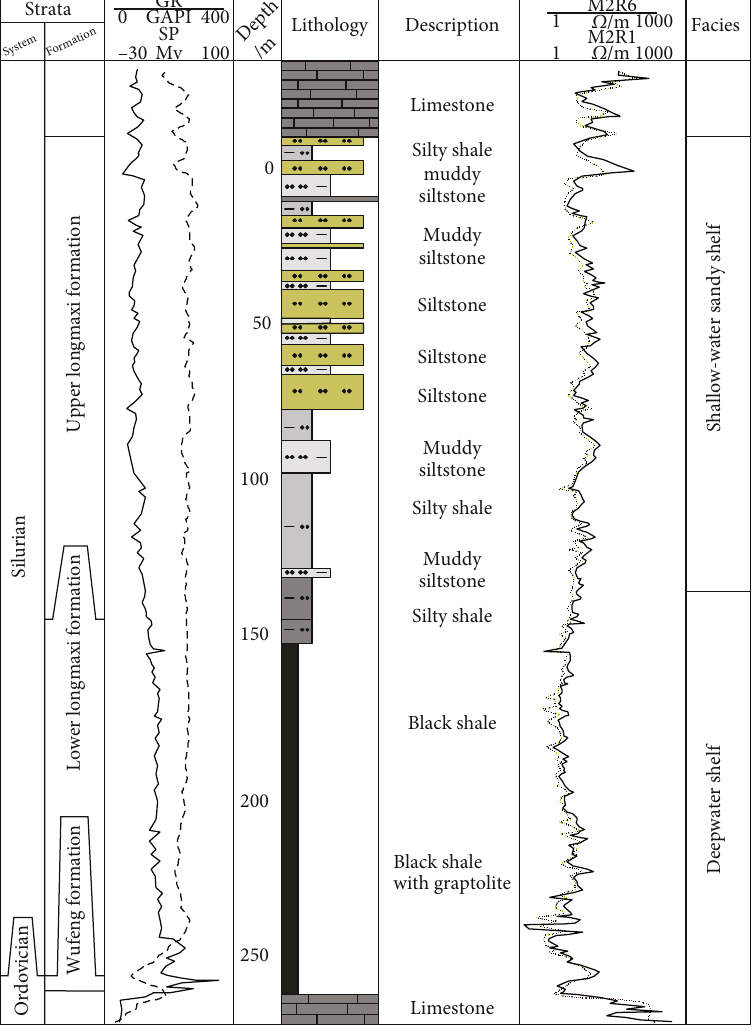
Figure 7: Sedimentary characteristics of the shale reservoir in the Longmaxi Formation, well XN111, Sichuan